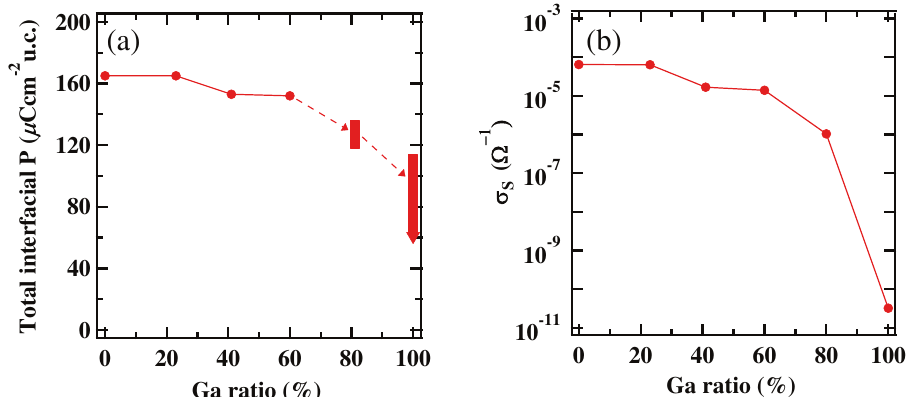
Fig. 7 Comparison of total interfacial polarization with sheet conductance. a The total interfacial polarization summed from Fig. 6a. The values for 81% LIGO were calculated from the estimated n 2D = 1 – 3 × 10 12 cm − 2 by assuming that n 2D and μ follow the decreasing trend shown in Fig. 1 as the alloying ratio increases. In the case of LGO, we found the minimum polarization value, about 113 μ C cm − 2 unit cell, which can produce non-zero n 2D by assuming a similar thickness dependence of the interface polarization. b Sheet conductance of 2DEG with 10-nm-thick LIGO as a function of Ga alloying